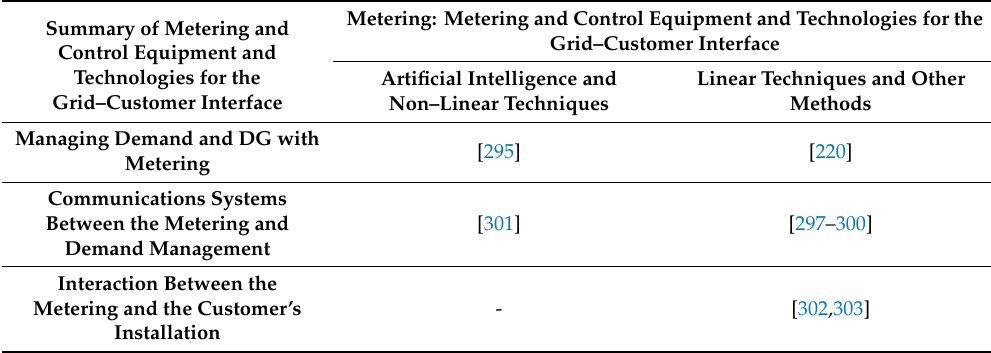
Table 15. Summary of Metering and Control Equipment and Technologies for the Grid–Customer Interface. Summary of Metering and Control Equipment